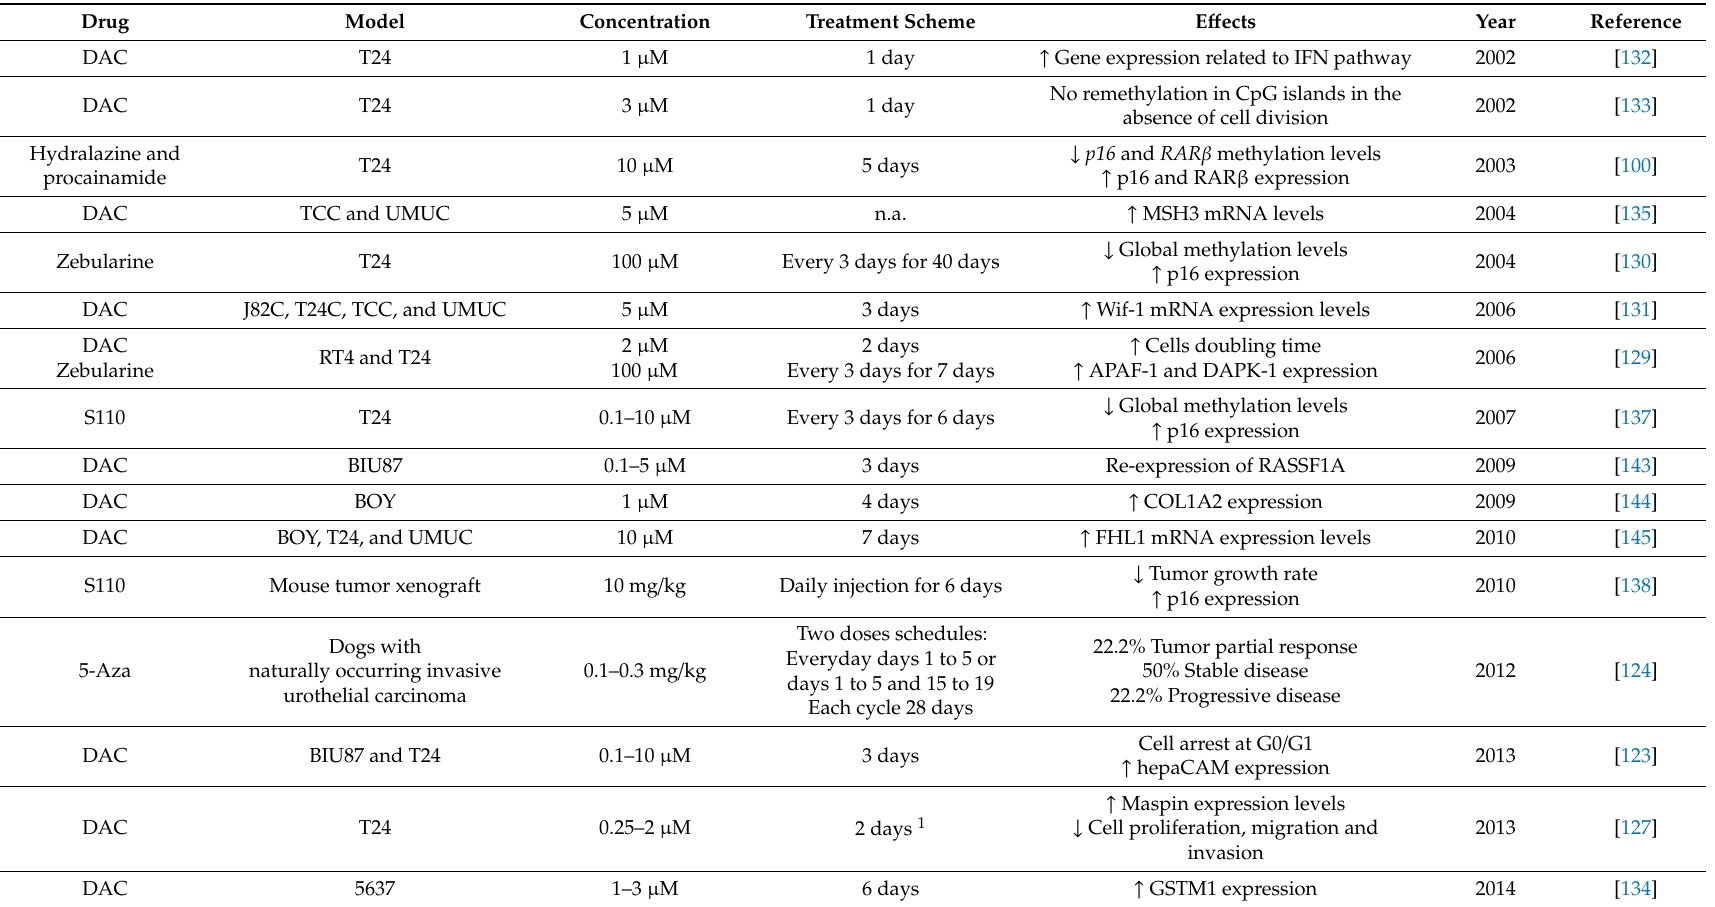
Table 1. Summary of pre-clinical studies targeting DNMTs in bladder cancer